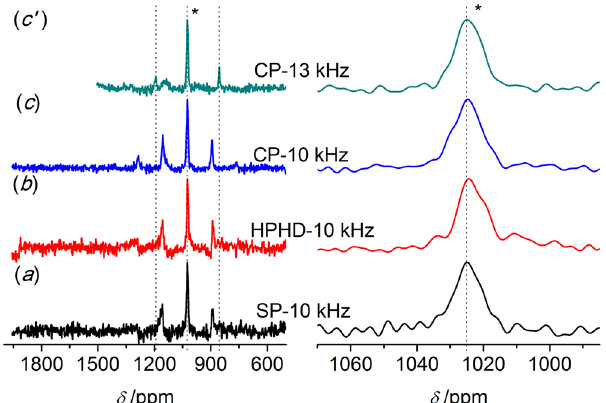
Figure 5. 77 Se MAS NMR spectra of polymer 6 (-SeO 3 H) obtained by different pulse sequences. ( a ) Single pulse(SP); ( b ) High power 1 H decoupling (HPHD); ( c, c ′ ) Cross polarization (CP), 17408 scans and the spinning speed of 10 kHz or 13 kHz. The isotropic peak is labeled with an asterisk ( * ).